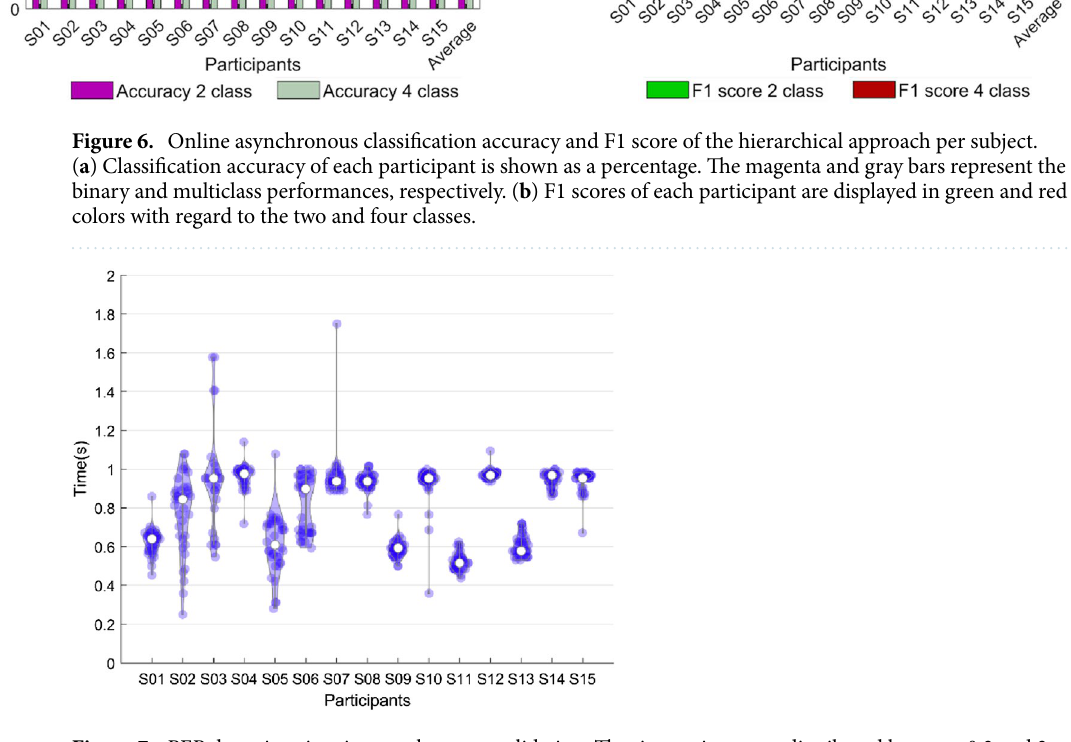
Figure 7. PEP detection time in asynchronous validation. The time points were distributed between 0.2 and 2 s in relation to perturbation onset. The average detection time of all subjects was less than 1